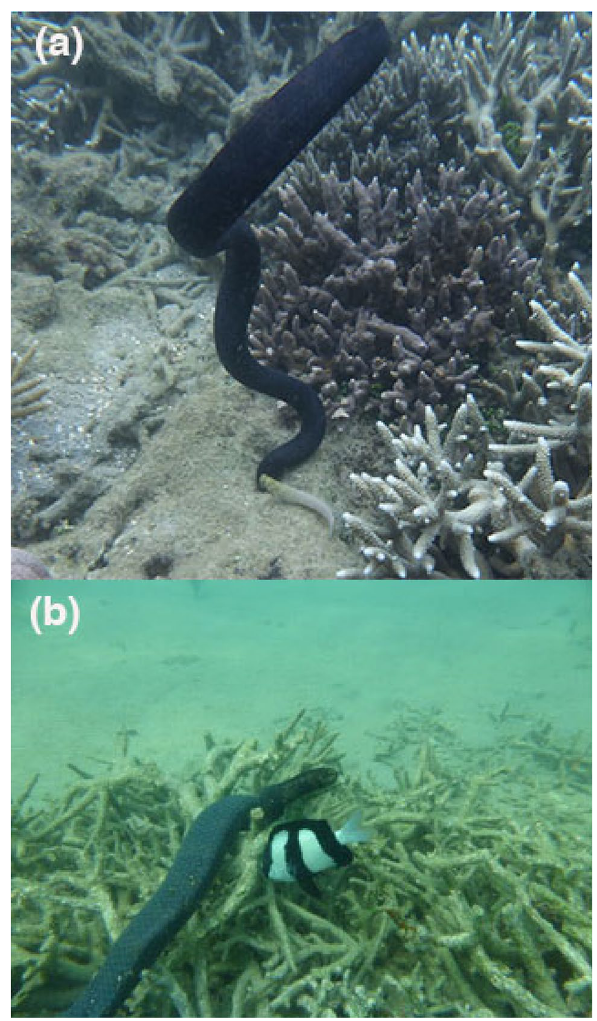
Figure 3. The only prey taken by Turtle-headed sea snakes, Emydocephalus annulatus , are the eggs of small demersal-spawning fishes. The snakes obtain some prey from burrows, and some from more open situations. Image ( a ) shows a snake with its head down the burrow of a blenny ( Salarius fasciatus ), consuming eggs, whereas image ( b ) shows a snake scraping eggs from a damselfish ( Dascyllus aruanus ) nest on exposed branching coral. In both cases, adult fish (parents of the eggs being consumed) ineffectually attack the snakes. Photographs by C.